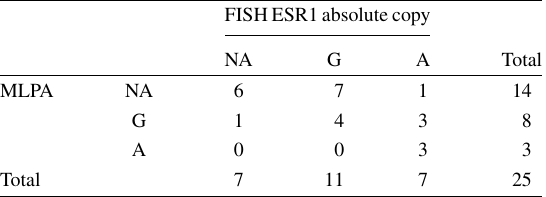
Concordance between ESR1 MLPA ratio and FISH absolute ESR1 copy number